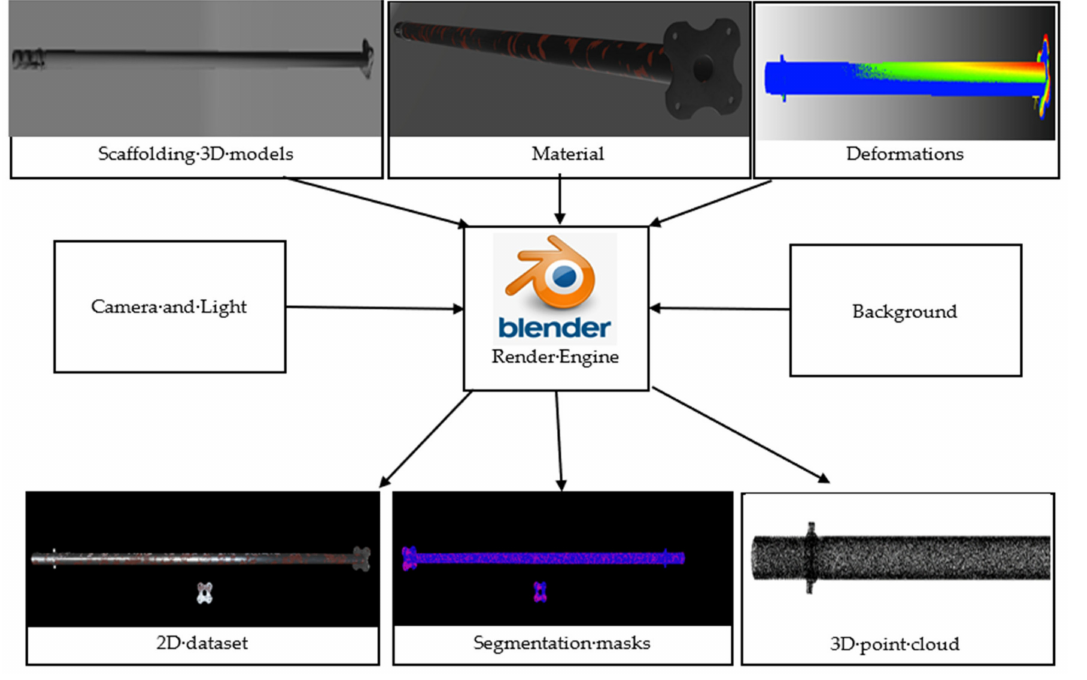
Figure 2. Dataset rendering flow chart.